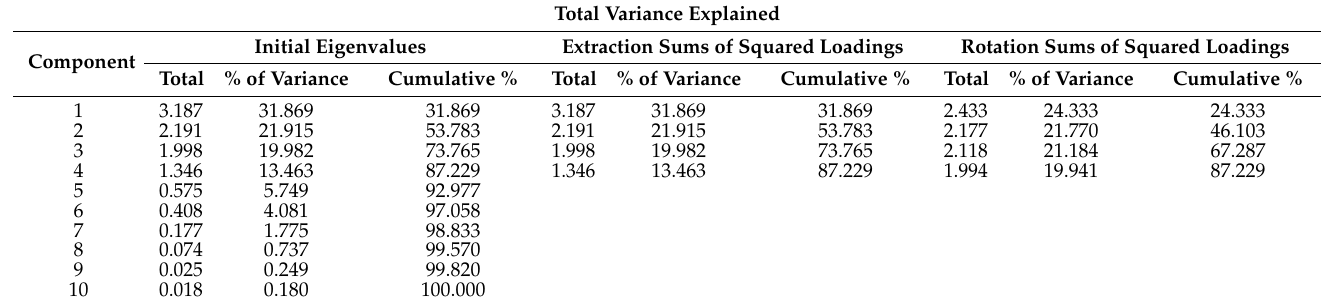
Table 6. Total variance explained and components extracted by principal component analysis. Total Variance